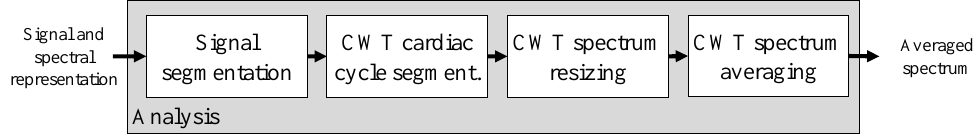
Figure 6. Proposed spectral analysis of the carotid sound